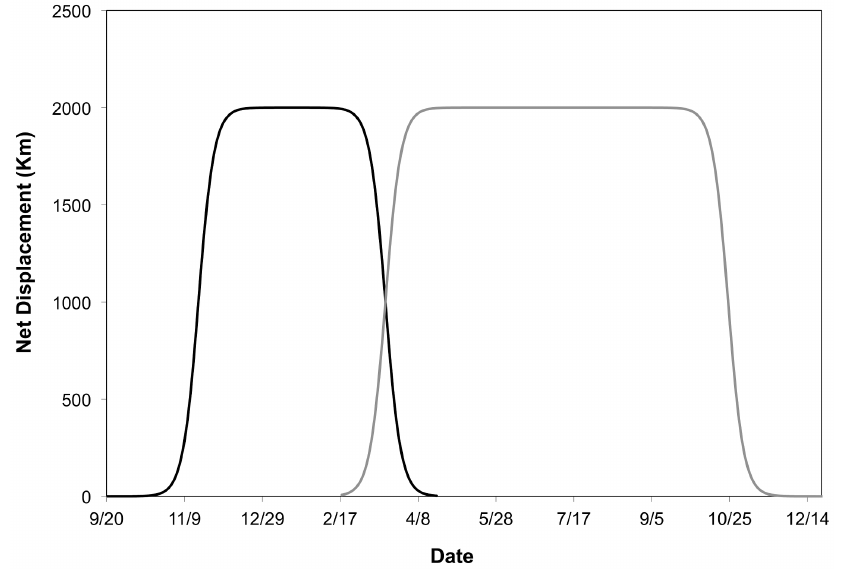
Figure 1. Predicted net displacement (ND) as a function of time for two idealized individuals. The black line represents a duck that was initially marked on the nesting grounds in Saskatchewan, Canada in September 2010. The gray line represents an individual that was marked on the wintering grounds in Arkansas, USA in February 2011.